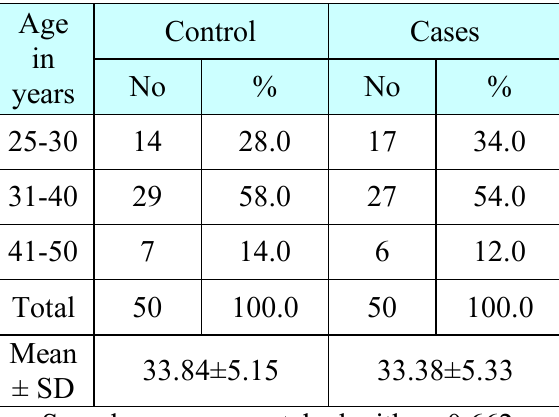
Table 2: The percentage of gender